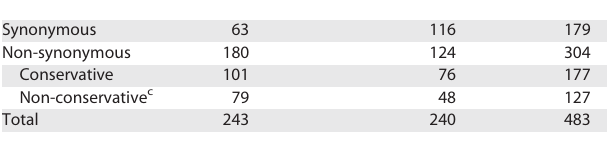
Table 2. Codon Changes due to Coding SNPs between QBL and PGF